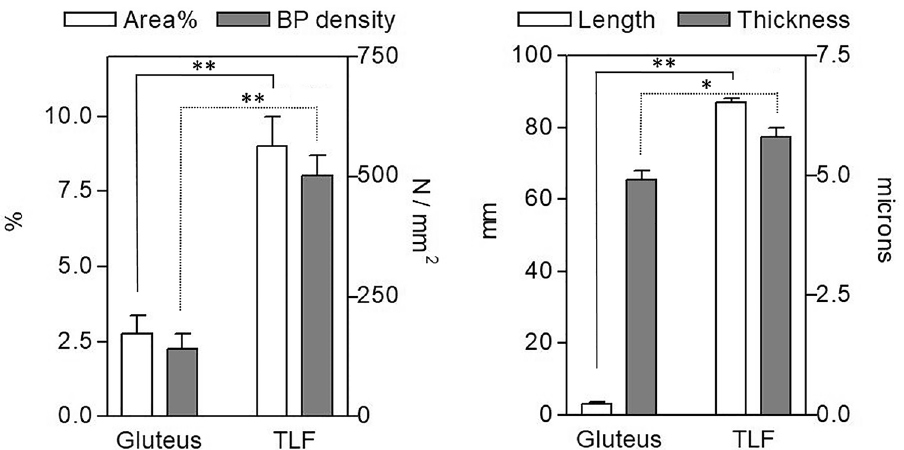
Figure 5. Morphometric analysis of the pattern of S-100 positive fibers in thoracolumbar and gluteal fascia: positive area (%), branching points (BP) density (number/mm 2 ), length of nerve structures (mm), thickness of nerve structures (µm) in thoracolumbar fascia (TLF) and gluteal fascia. *p < 0.05; **p < 0.01, t test.